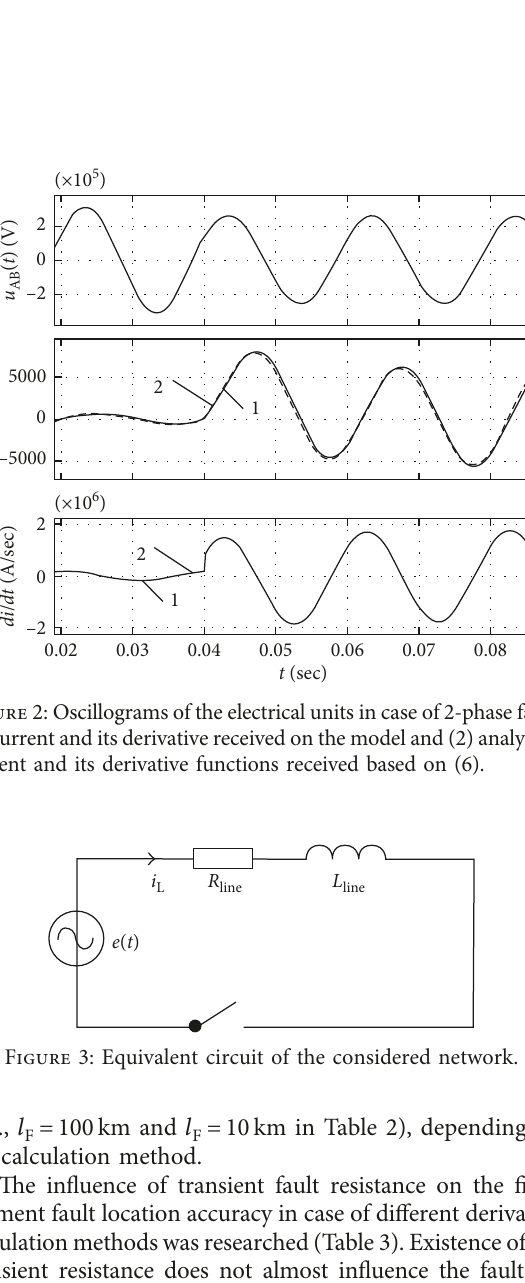
Table 6: Influence of the different methods of derivative calculation and different distances to the fault on the error of average fault location result.